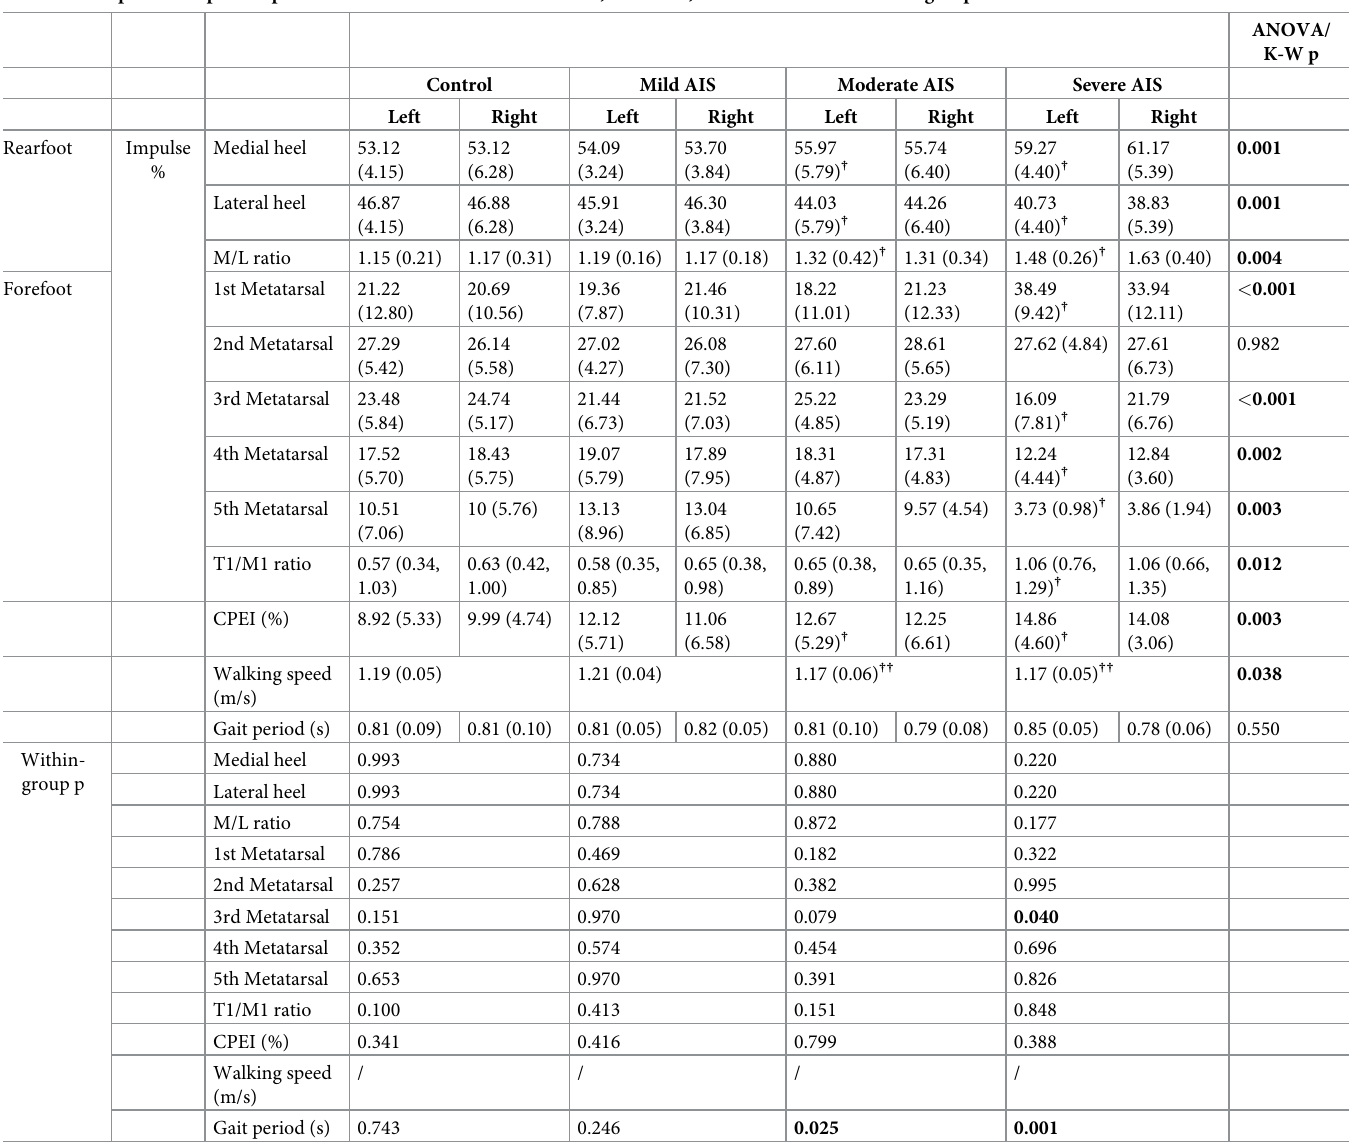
was found between the mild AIS and control groups. In the intra-group comparison, only the Table 4. Comparison of plantar pressure distributions between the mild, moderate, and severe AIS and control